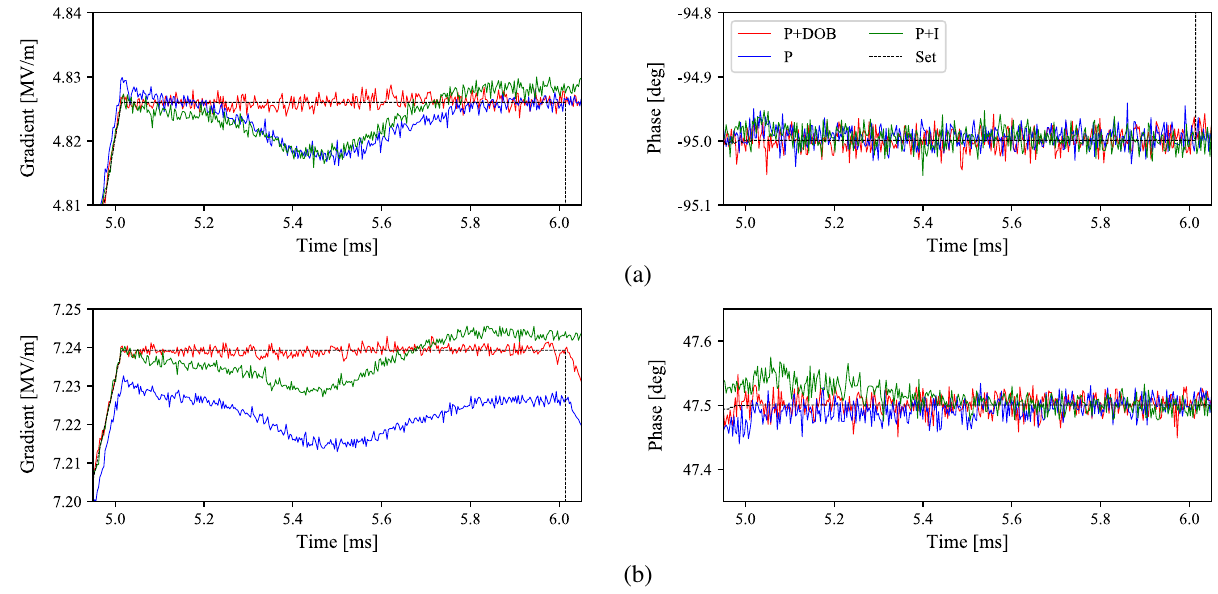
FIG. 21. Comparison of P control (blue) and P þ DOB control (red) on ML2 operated at 10.5 MV. (a) Amplitude and phase of DAC output. (b) Amplitude and phase of cavity gradient. The DOB controller is activated after approximately 3 ms delay of the rf gate. The filling on resonance technique is applied in the design of the pulse pattern.